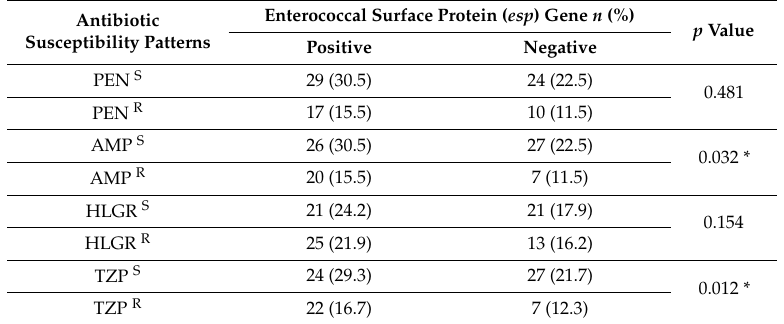
Table 2. The association between antibiotic susceptibility patterns and the esp gene among clinical